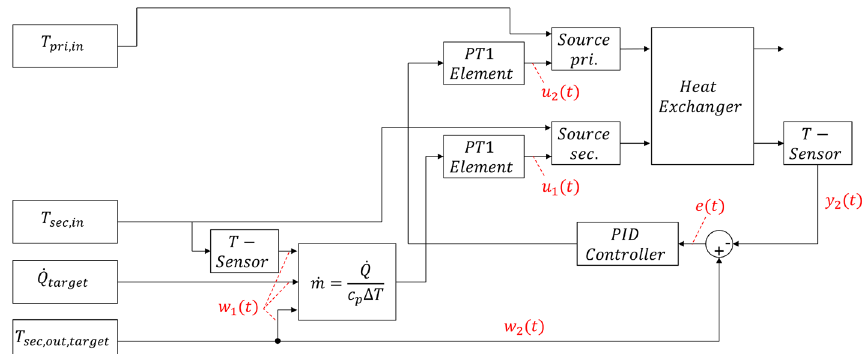
Fig. 6 Model structure of the control concept “decoupled PID controller” [own representation]